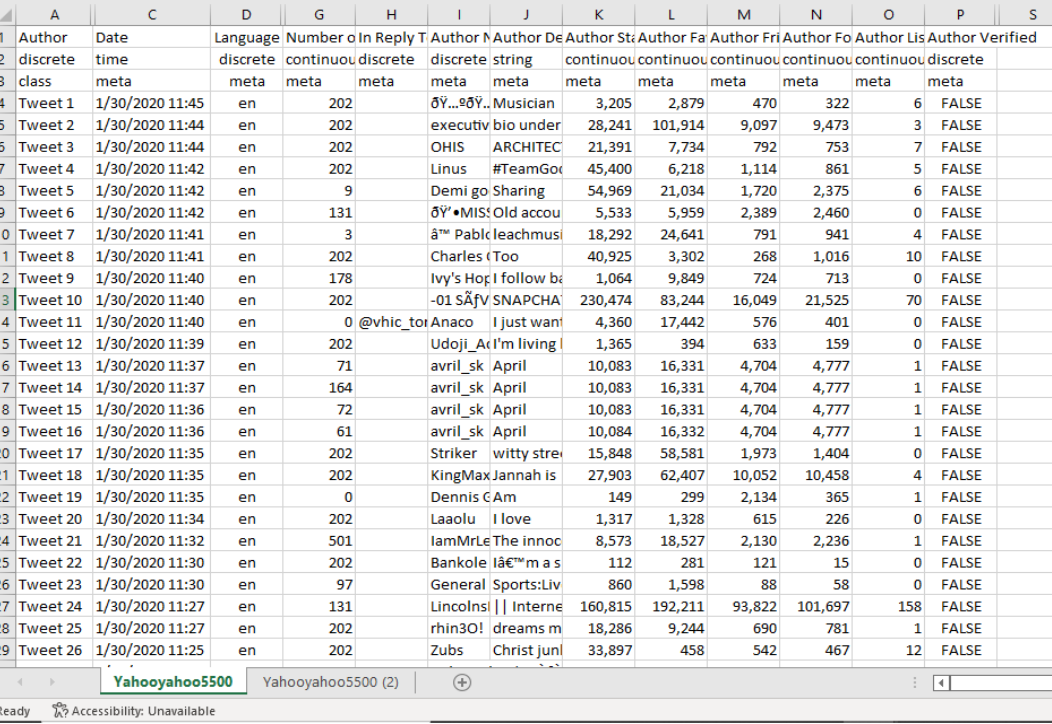
Figure 3. Screenshot showing the Data Table with the Tweet contents and other metadata.